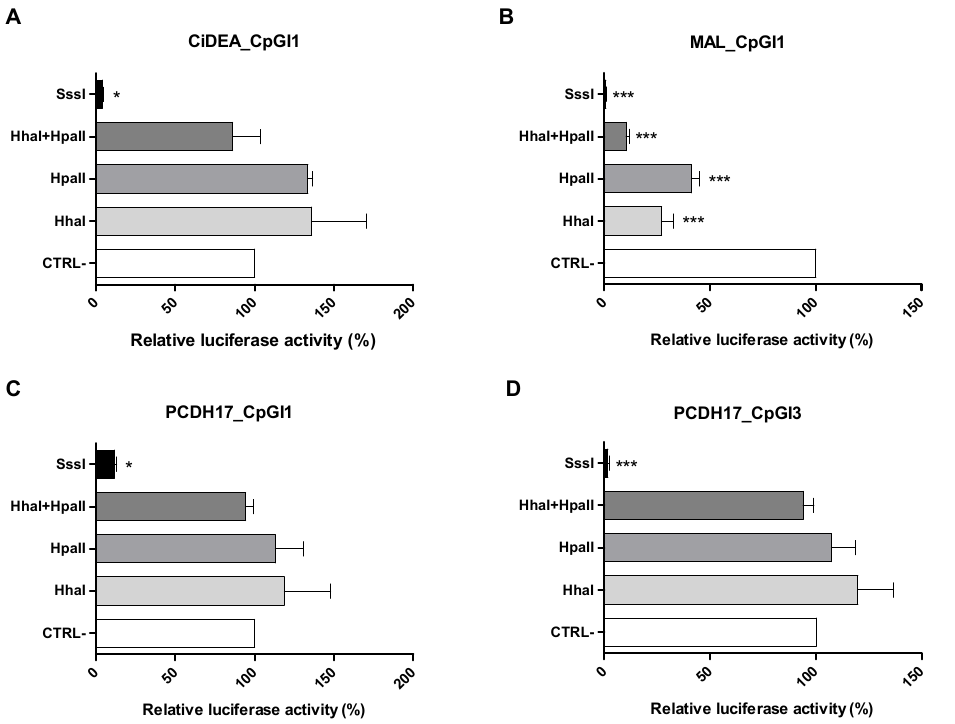
Figure 9. Luciferase activity of in vitro methylated CiDEA_CpGI1 ( A ), MAL_CpGI1 ( B ), PCDH17_CpGI1 ( C ) and PCDH17_CpGI3 ( D ) plasmids in CF2Th cells. Plasmids containing the CpG sites mostly involved in the regulation of CiDEA , MAL and PCDH17 transcription were subjected to in vitro methylation. SssI, HhaI and HpaII methylation enzymes were used separately or in combination (HhaI + HpaII). Luciferase activity values (mean ± SEM of three independent experiments) are expressed as the percentage of the negative control (CTRL-, the respective unmethylated plasmid) activity, to which an arbitrary value of 100% was assigned. Statistical analysis: ANOVA + Bonferroni post hoc test (*: p < 0.05; ***: p < 0.001).